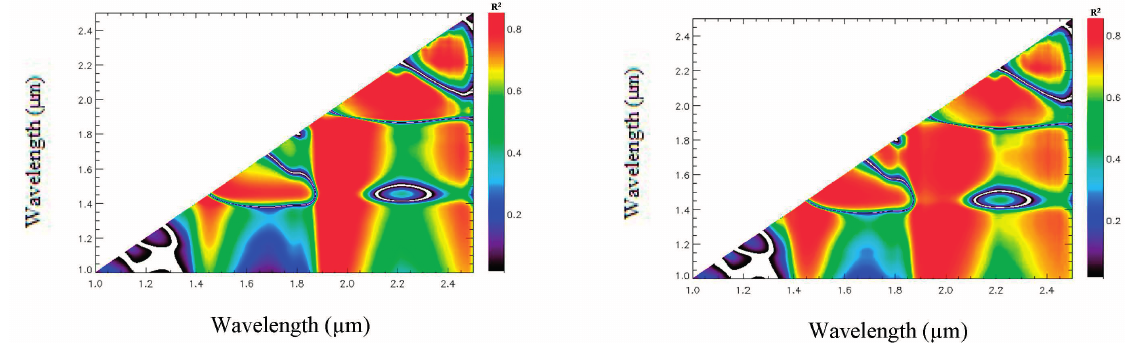
X λλ computed with the reference database in Figure 4. Determination matrix for ),( jinorm the (1–2.5 µm) domain by linear regression ( Left ) and non linear regression ( Right